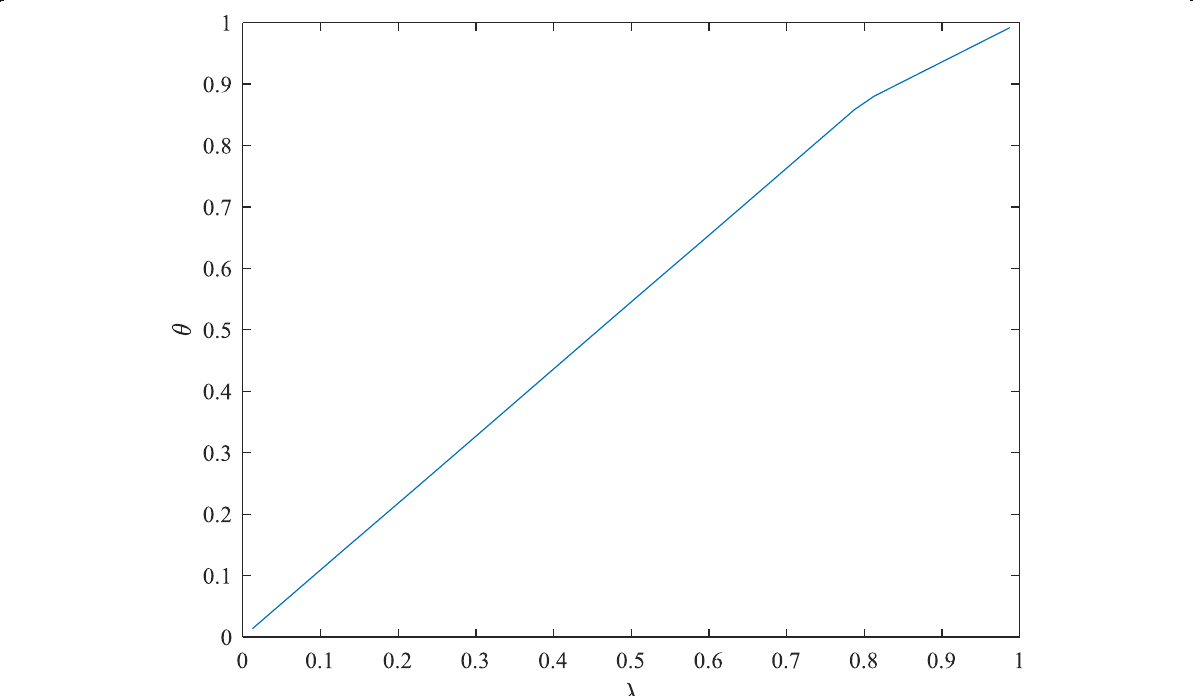
Fig. 5 Warping function based on Eq. (14) plotted for the emotional state of Happy in the Persian ESD database [17] with the warping factor p = 1.09, and λ 0 =